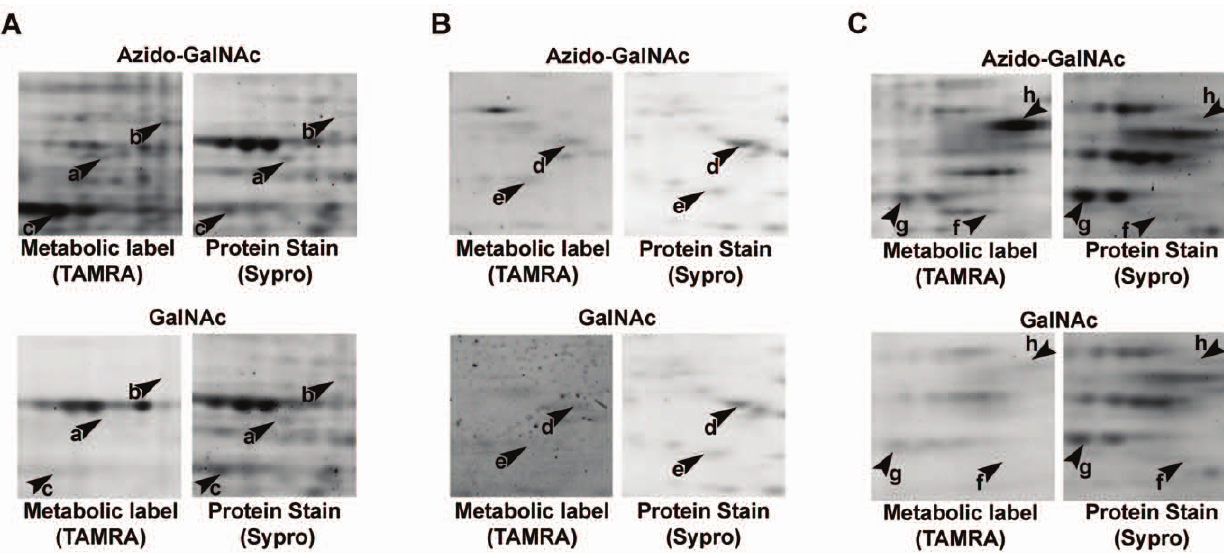
Figure 2. Azido-metabolic labeling of C.elegans cells generates glycoprotein candidates. C. elegans embryonic cells grown with 40 m M azido-GalNAc (top panels) or 40 m M GalNAc (bottom panels) were reacted with TAMRA-alkyne and fractionated by 2DE. (A), (B), and (C) each show a different field of view representative of two independent experiments. Within each field of view, metabolically labeled glycoproteins were detected in-gel by their TAMRA fluorescence (left panels). And subsequently, the total protein profile of the sample was visualized with Sypro protein stain (right panels). Arrowheads mark glycoprotein candidates that met the criteria listed in Results and Discussion. Some spots marked with arrowheads were cut from the gels shown while others were cut from the gels of the other independent experiment. MALDI-TOF/TOF identified the following C. elegans proteins within each arrowhead-marked spot: (a) ATP synthase a -subunit (H28O16.1); (b) Acyl CoA Dehydrogenase family member ( acdh-12 ); (c) Ubiquinol-Cytochrome c oxidoreductase complex family member ( ucr-2.3 ); (d) Actin (peptides shared by ACT-2, ACT-3, and ACT-4 were observed); (e) TCTP (translationally-controlled tumor protein) homolog family member ( tct-1 ); (f) Aspartyl protease family member ( asp-4 ); (g) Tubulin, Beta family member ( tbb-1 ); (h) Tubulin, Beta family member ( tbb-1 ). TBB-1 was found in two different 2DE spots likely due to post-translational modification or proteolytic processing.